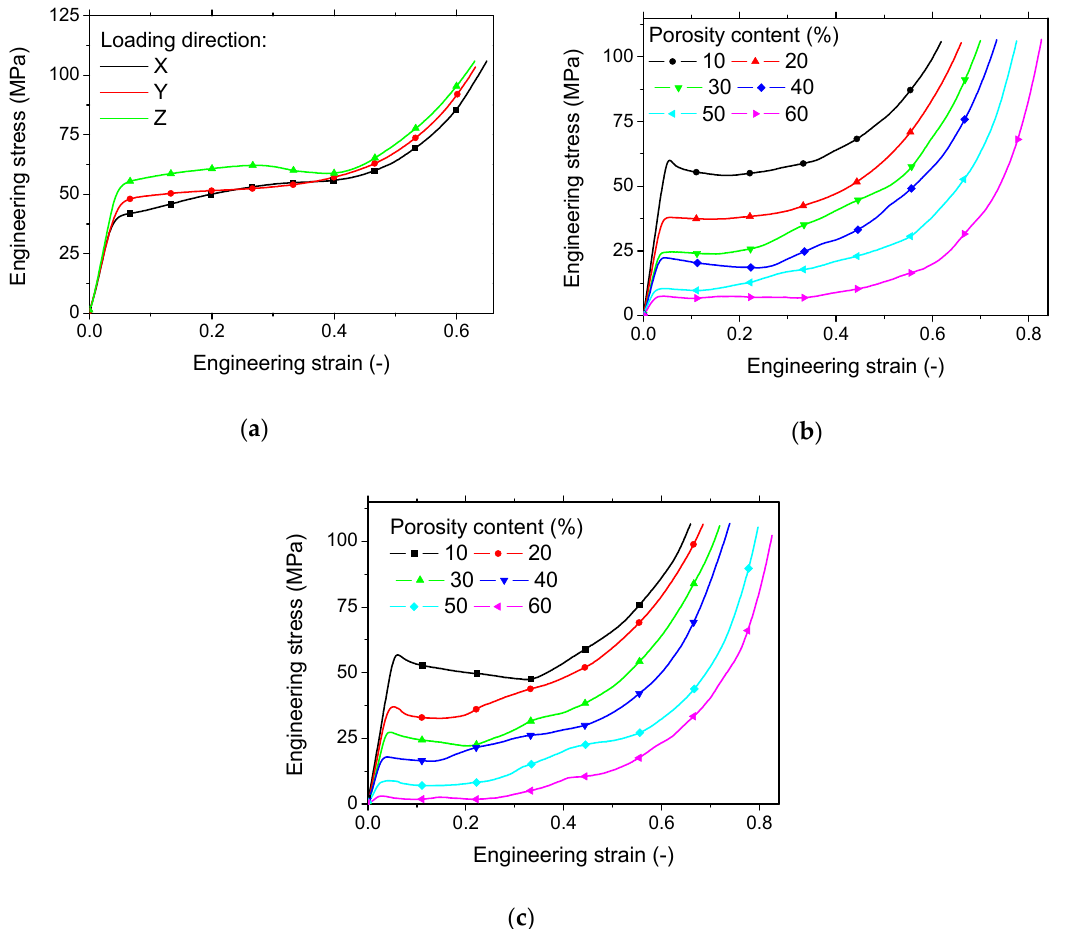
Figure 2. Compression response of ( a ) 3D printed dense PLA in all loading directions, and 3D printed cellular PLA as a function of the porosity content for loading in ( b ) Z- and ( c ) Y-directions. Z is the building direction.